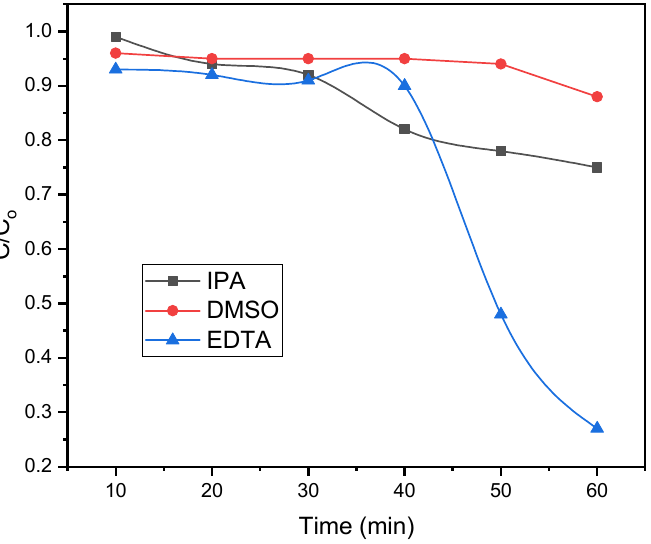
Figure 13. Evaluation of effect of EDTA, IPA and DMSO as scavengers in photodegradation studies (C is the final concentration and C 0 is the initial concentration in mgL − 1 ).